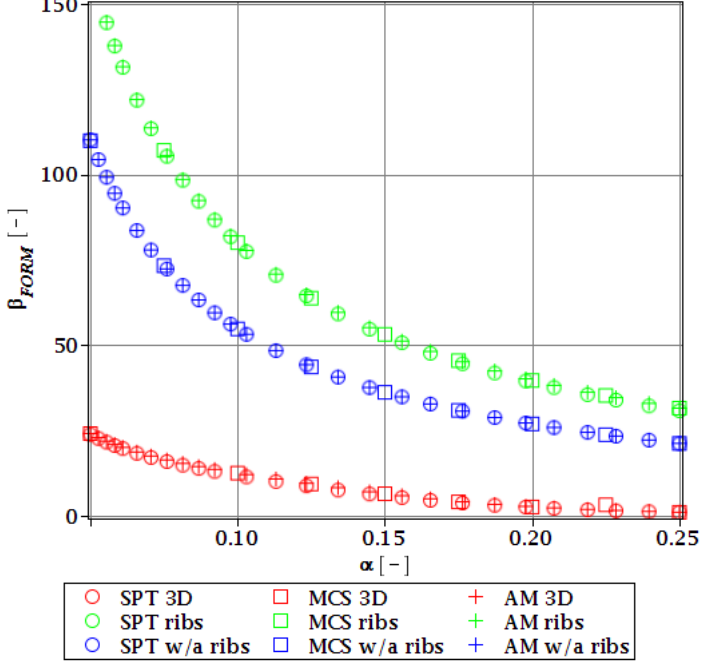
Figure 21. Reliability index of the corrugated I-beam for three ABAQUS models according to FORM and based on the critical load.